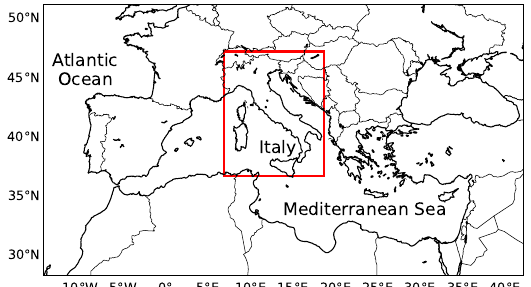
Figure A1. Domain of the HyMeX/MED-CORDEX simulation covering Europe and the Mediterranean region. The rectangle indicates the domain of investigation of this